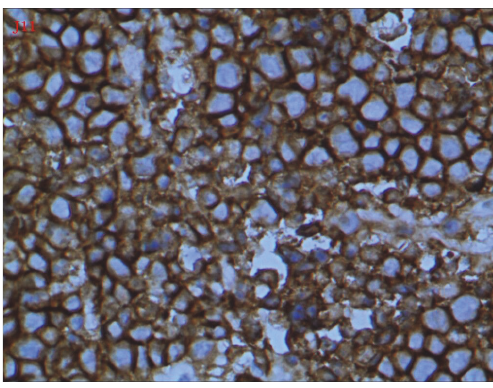
Figure 5: X400, Syn, positive.